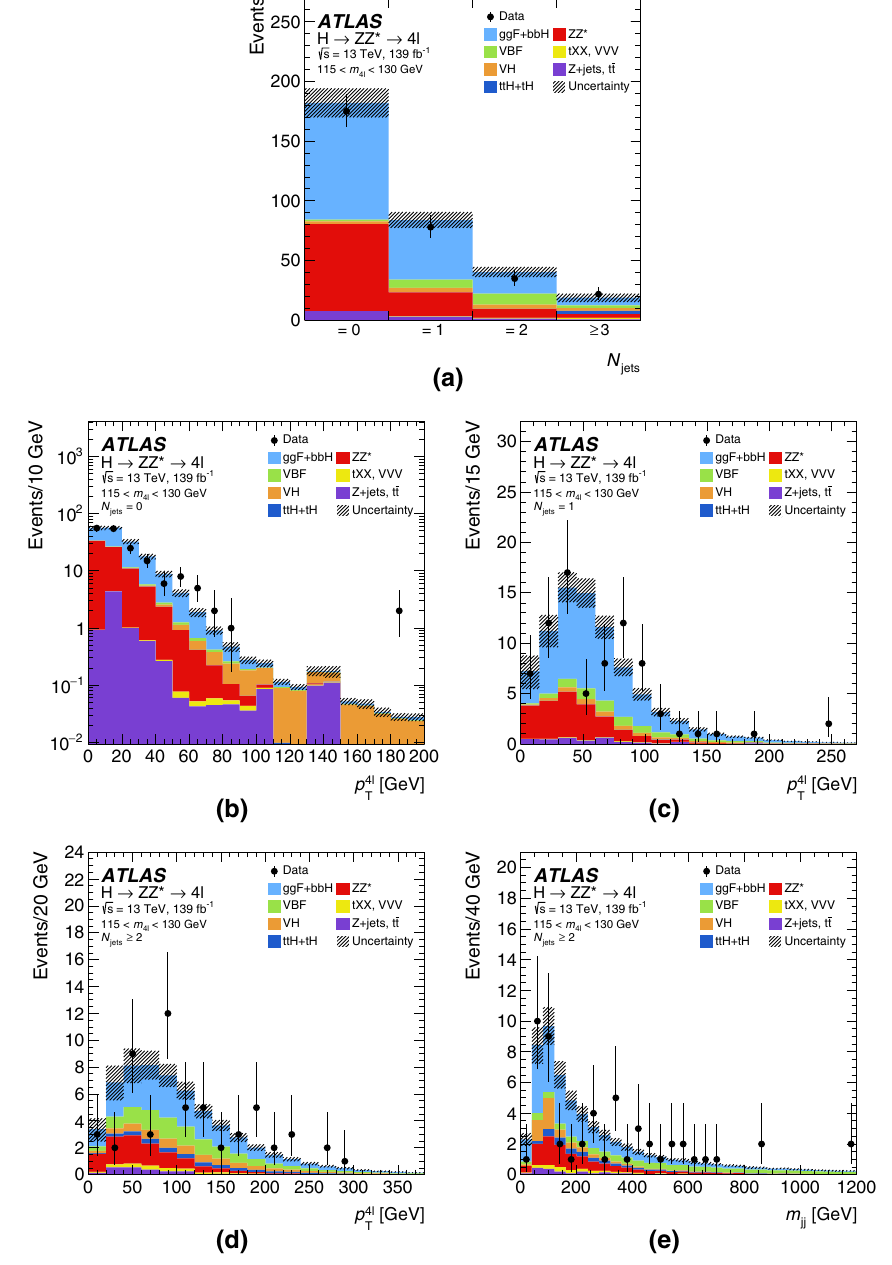
Fig. 6 The observed and expected distributions (post-fit) of ( a ) the signal is assumed to have a mass m H = 125 GeV. The uncertainty in jet multiplicity N jets after the inclusive event selection, the four-lepton the prediction is shown by the hatched band, calculated as described in Sect. 7. For comparison only, the hatched band includes the theoretical for events with ( b ) exactly zero jets, ( c ) with transverse momenta p 4 (cid:4) T uncertainties in the SM cross-section for the signal and the background exactly one jet and ( d ) with at least two jets and ( e ) the dijet invari- processes ant mass m jj for events with at least two jets. The SM Higgs boson